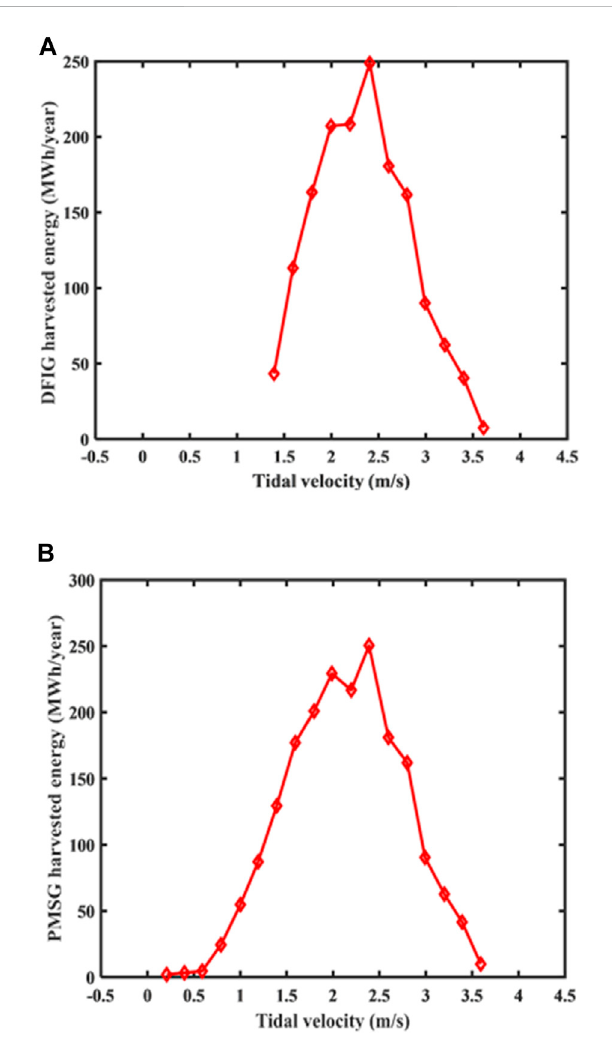
FIGURE 7 Comparison of energy ranges harvested by (A) DFIG-based system and (B) PMSG-based system (Benelghali et al.,